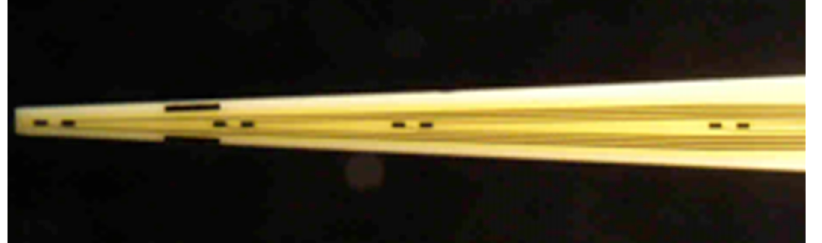
Figure 2. Detail of 8-TRK probe used in this project (CenMeT, University of Kentucky, Lexington, KY, USA). Each recording site is 50 × 100 µ m. Recording site pairs have 100 µ m separation. The spacing between recording site pairs is 1 mm, 1 mm, and 2 mm